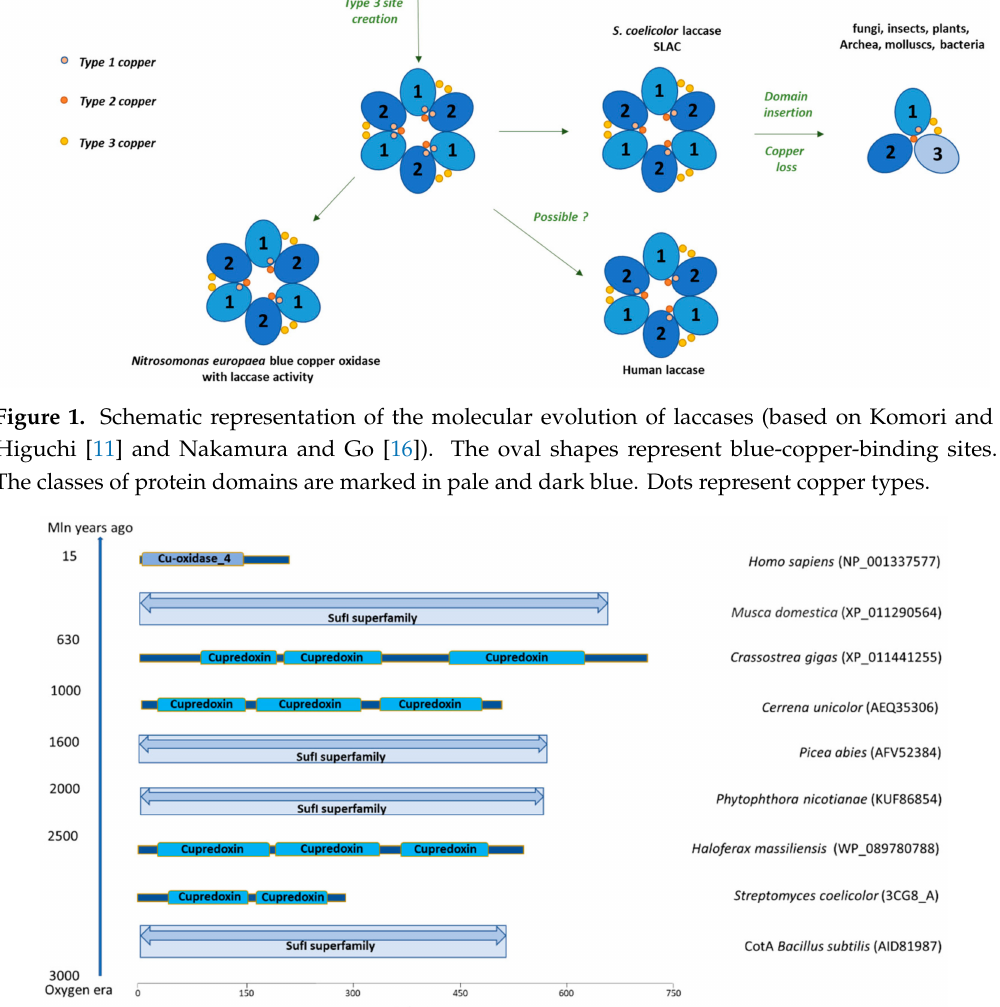
Figure 2. Conserved cupredoxin (cyan) laccase domains in di ff erent taxonomic groups. Cu-oxidase_4 is a multicopper polyphenol oxidoreductase laccase. Suf I represents a multicopper oxidase with three cupredoxin domains (includes cell division protein FtsP and spore coat protein CotA). The conserved domains were retrieved from the NCBI database. The appearance of organisms is shown in the timeline on the left in milliom (mln)